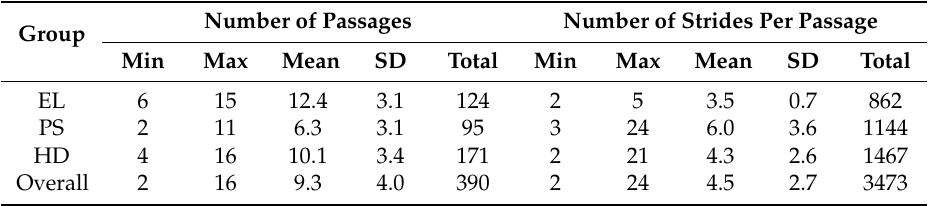
Table 2. Dataset